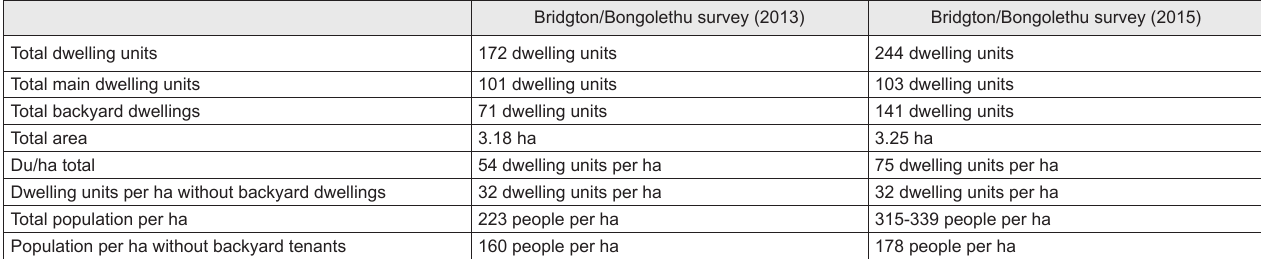
Summary of density findings for the Bridgton/Bongolethu surveys